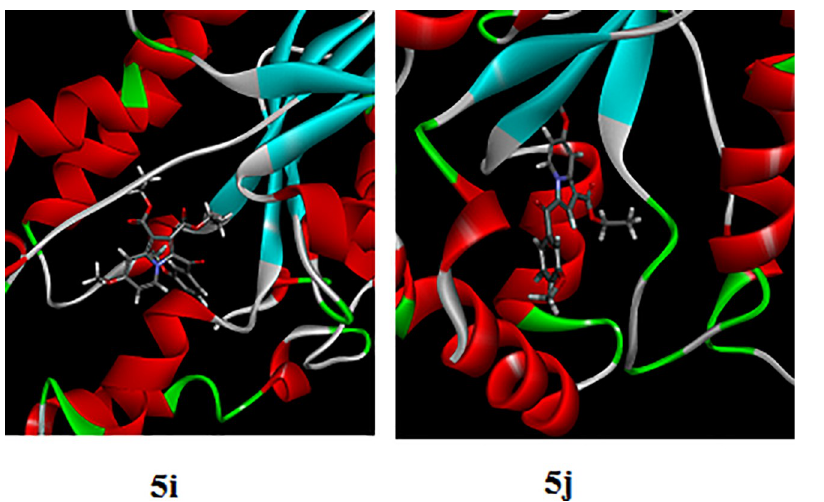
Fig 10. The interaction of ligands 5i and 5j at the active site of the enoyl-[acyl-carrier] protein-reductase enzyme following simulation.